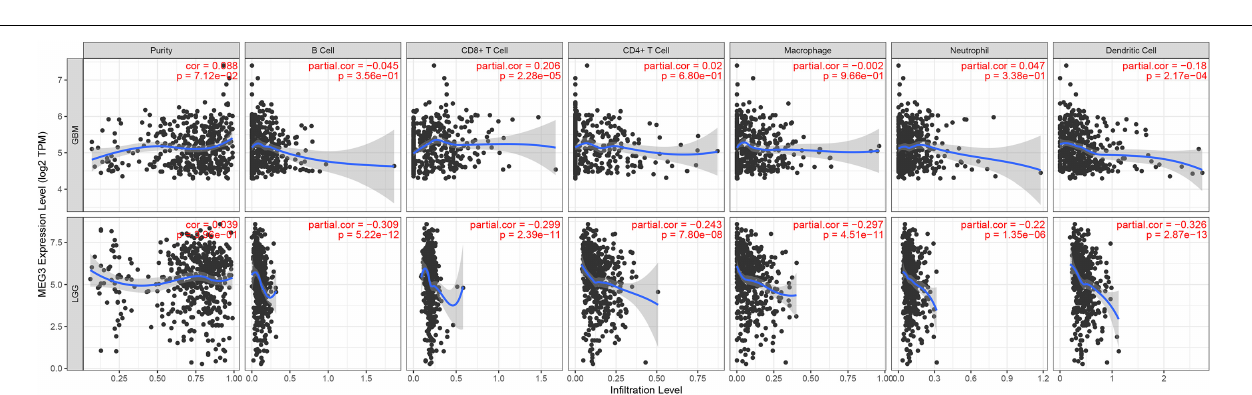
FIGURE 3 | Forest plot displaying the prognostic results for MEG3 generated by using the PrognoScan database.